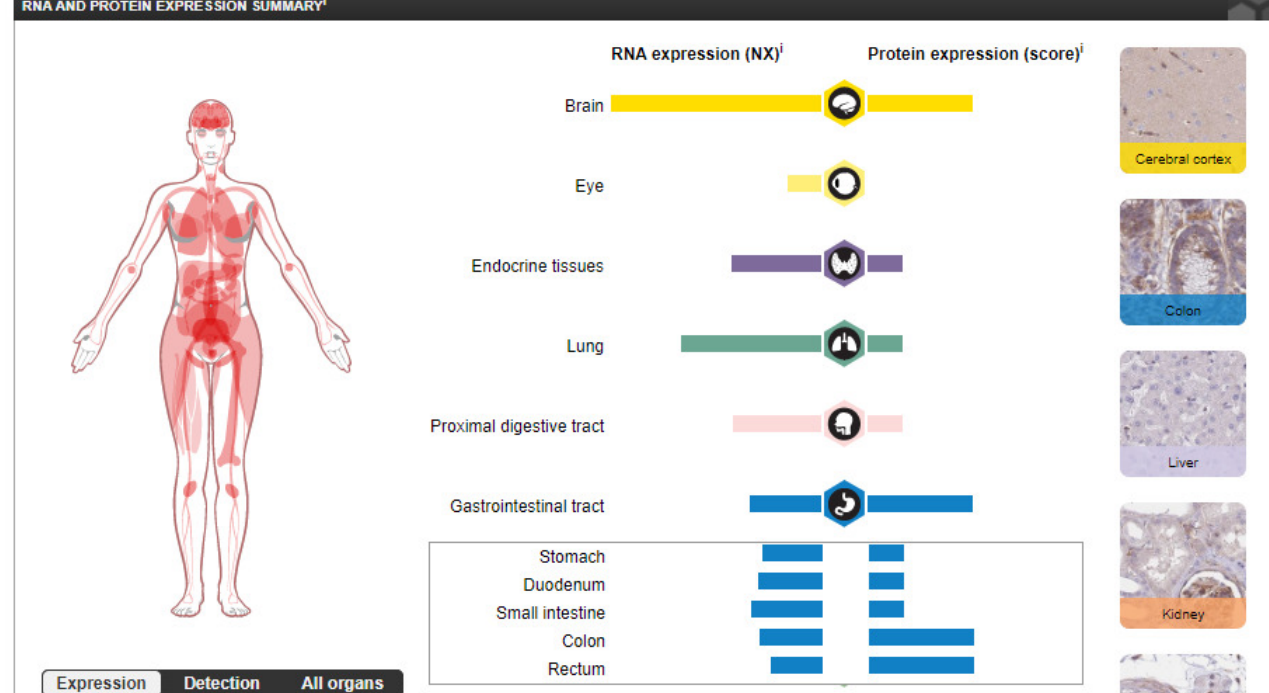
FIGURE 6 - Expression of CDC25B in organic systems. Nuclear and cytoplasmic expression in several tissue types, most abundant in the gastrointestinal tract and lymphoid tissues.